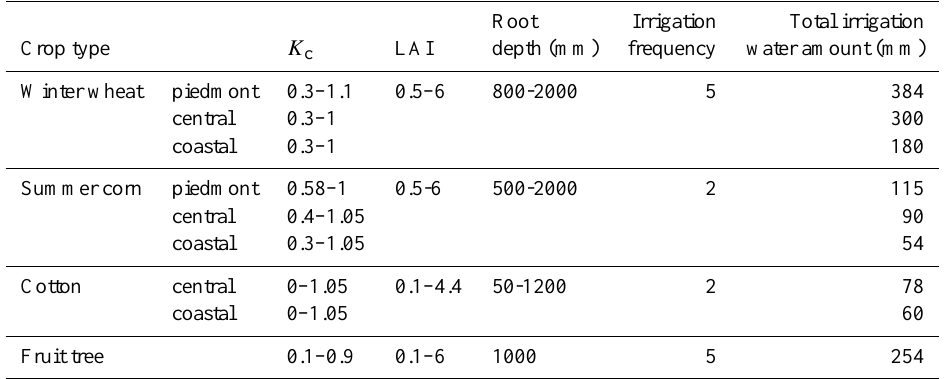
Table 3. Typical values for LAI, K c and root depth for different crops (Liu et al., 2002; Kendy et al., 2004; Zhang et al., 2004; Shu et al., 2012) and irrigation frequency and total irrigation water amount for these